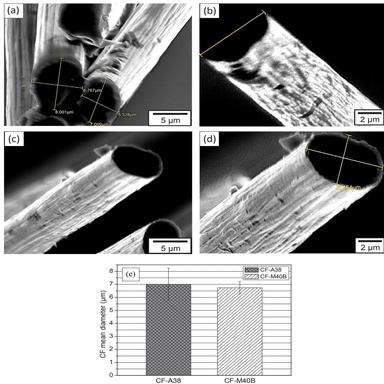
SEM images of CF-A38 (3a, 3b) and CF-M40B (3c, 3d) at lower (left-hand side) and higher (right-hand side) magnifications, respectively. (3e) The mean diameter of CFs investigated in this study (statistical averaging of 20 single measurements for each CF type), together with the corresponding standard deviations.